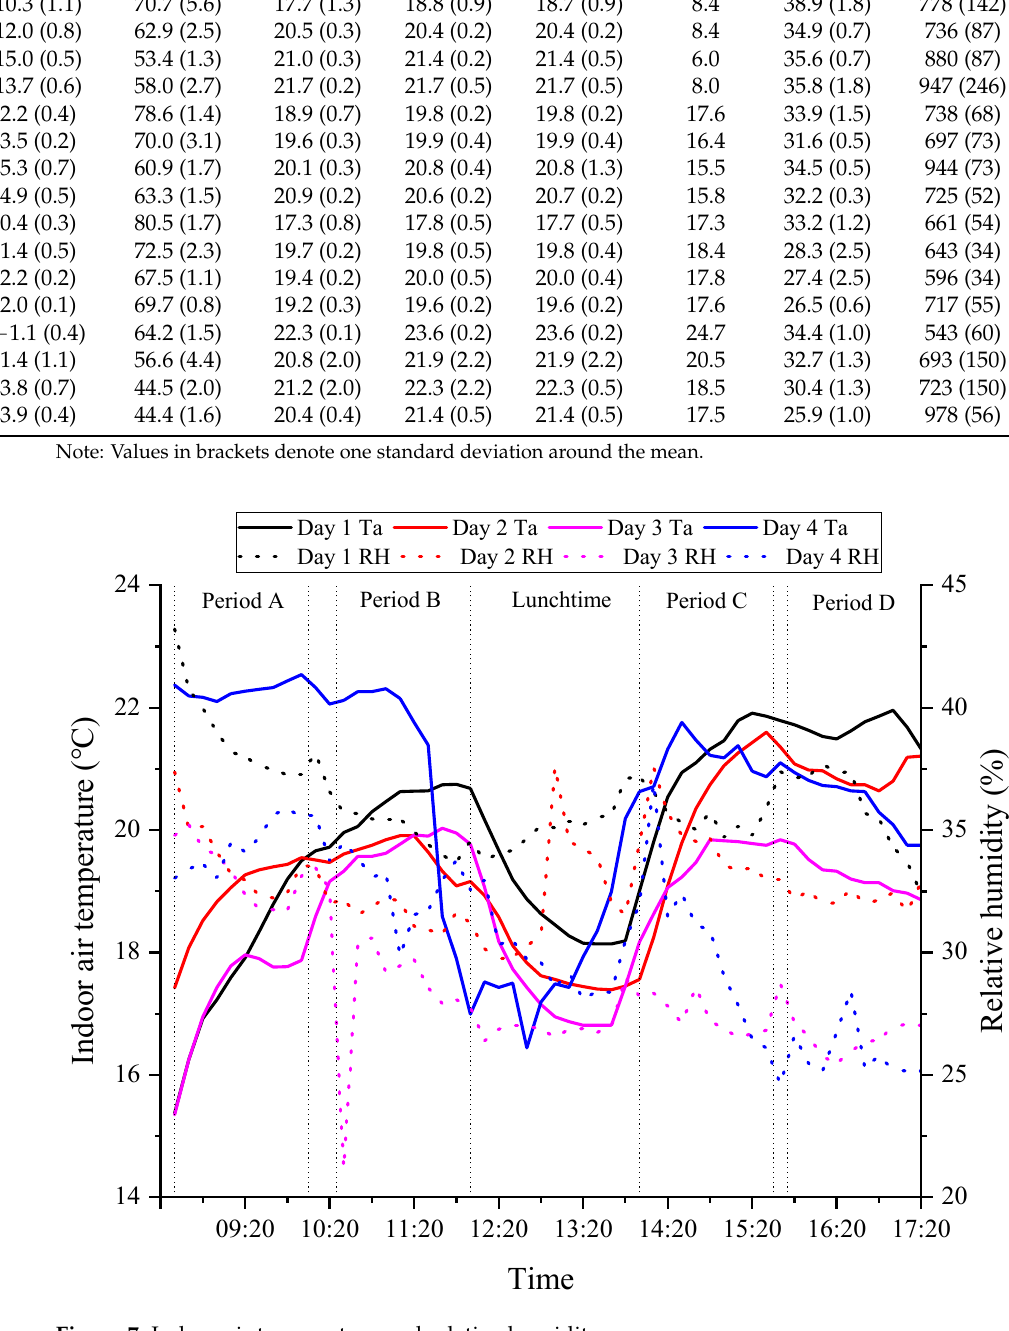
Figure 7. Indoor air temperature and relative